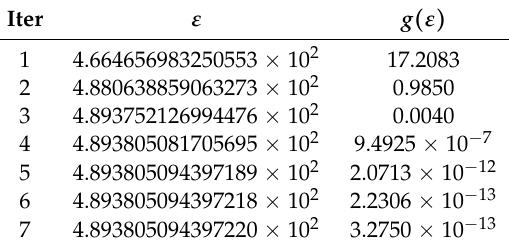
Table 4. Computational results got by employing the function g ( ε )